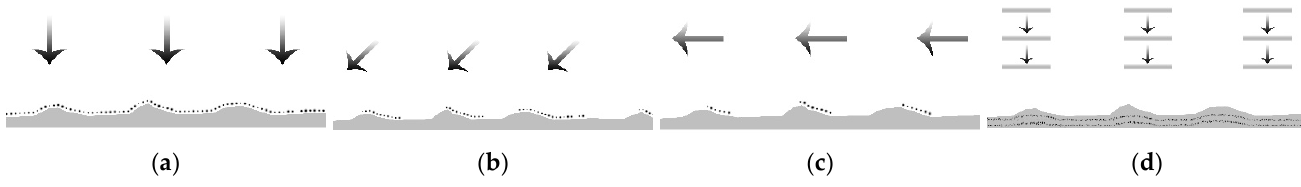
( d ) mid-layer pigmenting (Konrad Urbanowicz).